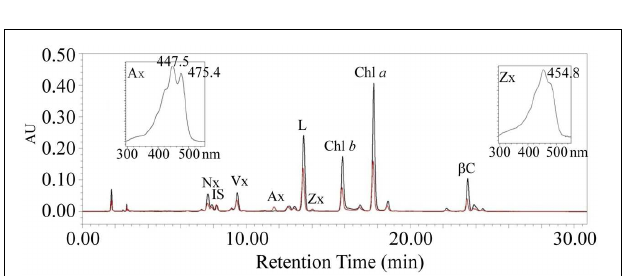
FIGURE 5 | Western blot showing that PSA2 localizes predominantly in stroma lamellae. (A) Purified chloroplasts (CP) were separated into the thylakoid membrane (TM) and stroma (ST) fractions, separated by SDS-PAGE, blotted and probed with the antiserum against PSA2. LHCB2 and RbcL were probed as controls. (B) Thylakoid membranes were furtherly subfractionated into stroma lamellae (SL), grana margin (GM), and grana core (GC) fractions, separated by SDS-PAGE, blotted, and probed with the antiserum against PSA2. PsaA was probed as a control.